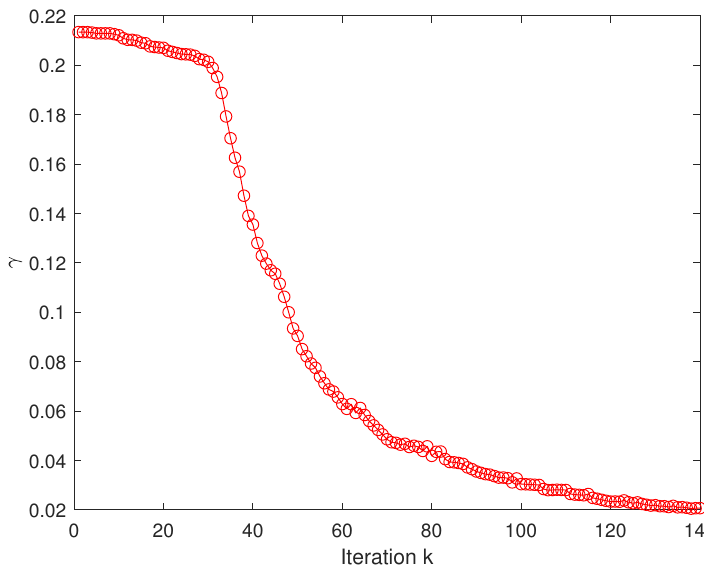
Figure 1. Evolution γ by the proposed